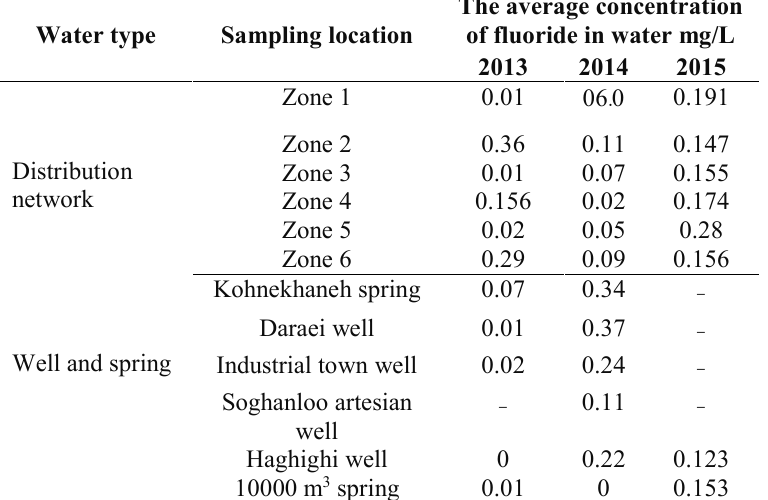
Table 1 Fluoride concentration in drinking water in Piranshahr during 2013 to 2015